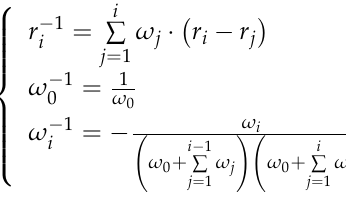
Figure 14. Feedforward compensation control schematic.